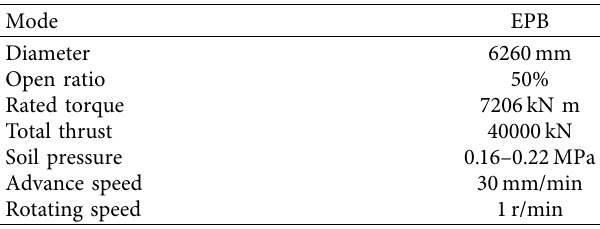
Table 9: Tunneling parameters of cutter